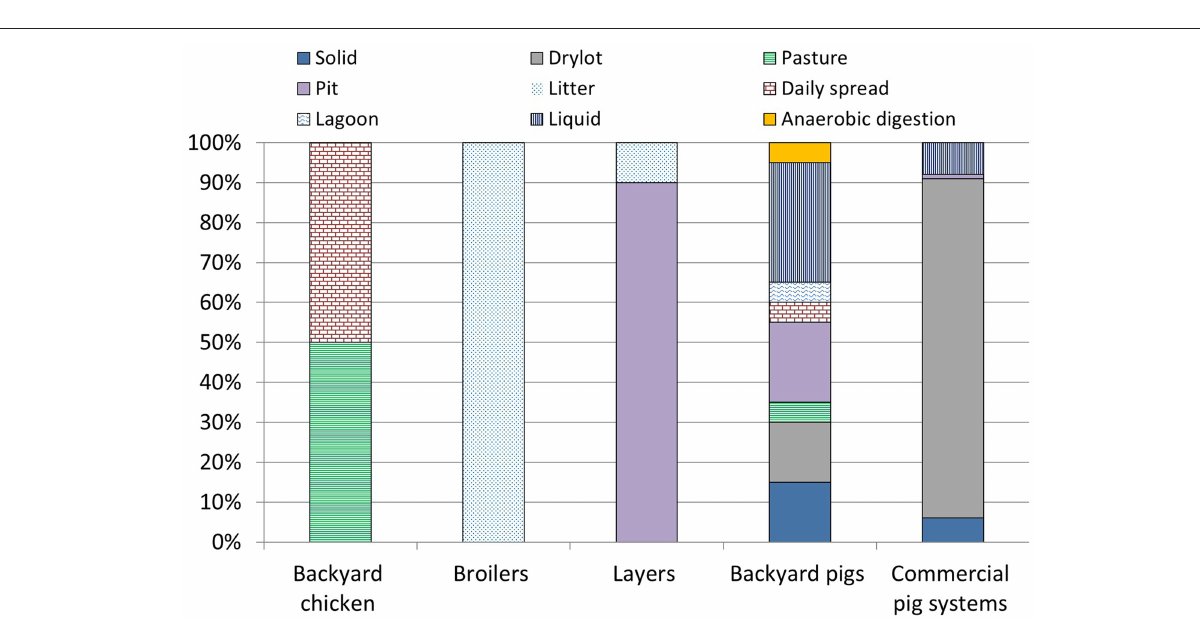
impermeable floor and without a roof, leaving it susceptible to nutrient losses by rain and